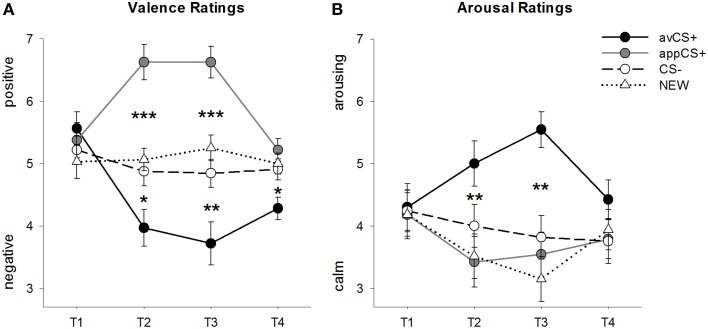
Ratings for valence (A) and arousal (B). Lines (with standard errors) depict the ratings after the habituation phase (T1), Acquisition 1 (T2), Acquisition 2 (T3), and the extinction phase (T4). The aversive CS+ (black solid line) acquired negative valence and high arousal after the two acquisition phases compared to the CS– (black dashed line) and the NEW (black dotted line). Importantly, the appetitive CS+ (gray solid line) acquired positive valence compared to the CS– and the NEW. *p < 0.05, **p > 0.01, ***p < 0.001.